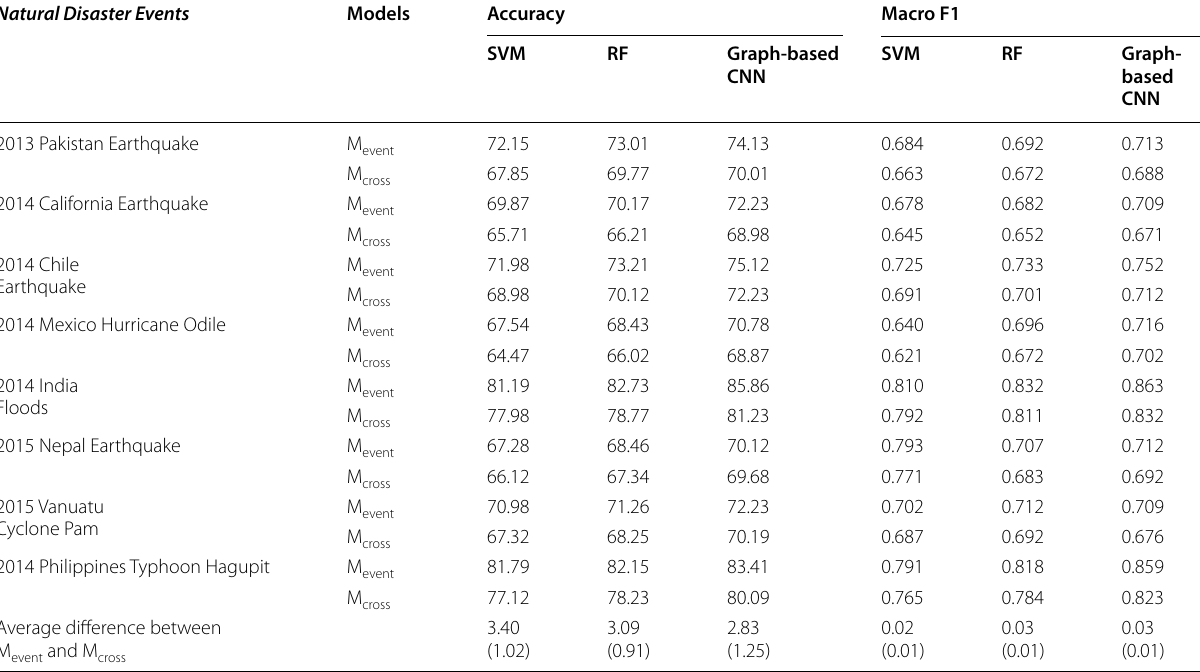
Table 3 Multi-class classification results of tweets (humanitarian-level situational awareness) Natural Disaster